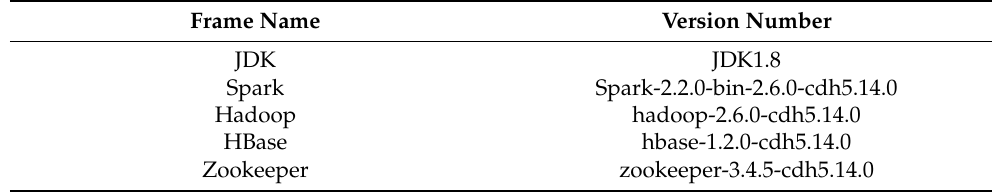
Table 2. Framework version.